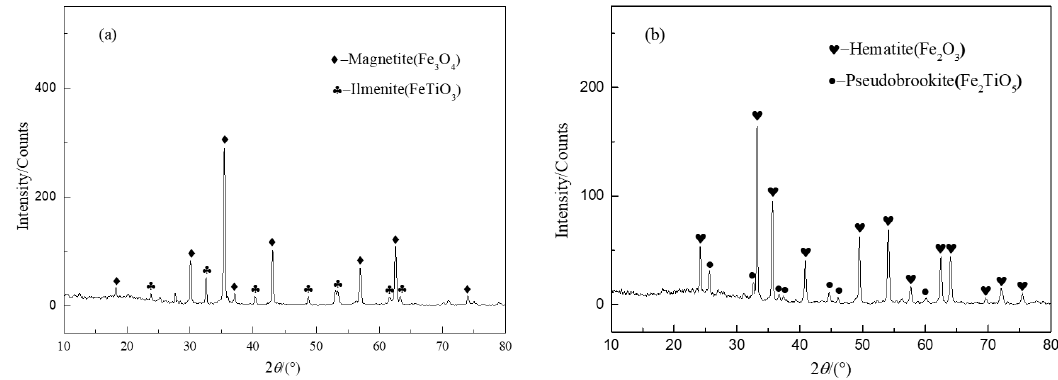
Figure 1. XRD patterns of the sample: ( a ) the VTM; ( b ) the oxidized VTM pellets. Table 1. Main chemical compositions of oxidized VTM pellets (wt %).